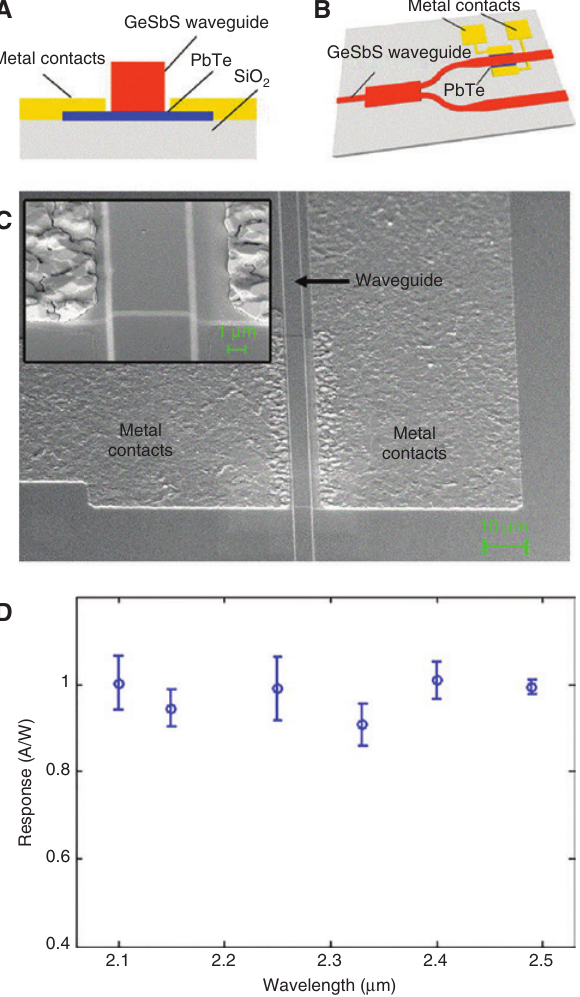
Figure 13: Mid-IR waveguide-integrated PbTe photodetector. (A, B) Schematic structure of the waveguide-integrated PbTe detector on Si, (C) tilted-view SEM image of the device, (D) measured respon- sivity of the detector showing a flat spectral response between 2.1- and 2.5- μ m wavelength [179] (© 2016 AIP Publishing